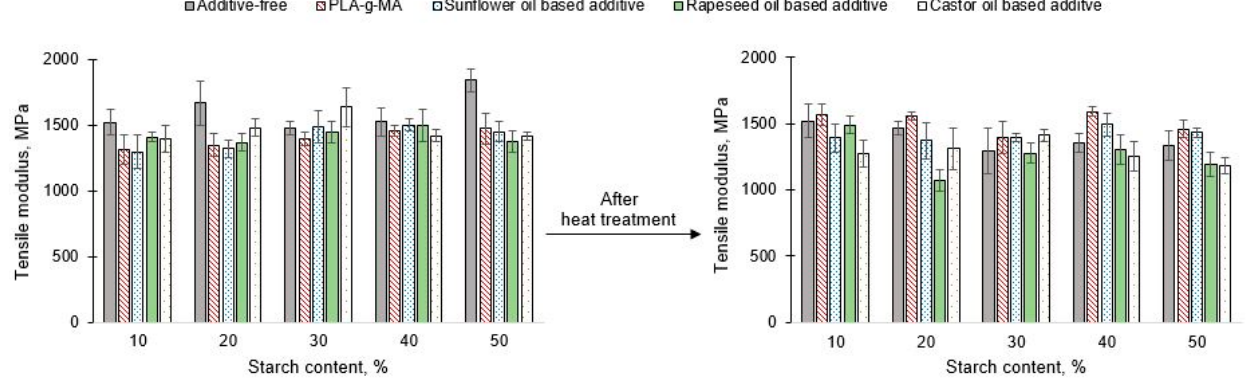
Figure 8. Tensile modulus of unconditioned and conditioned PLA/starch blends.